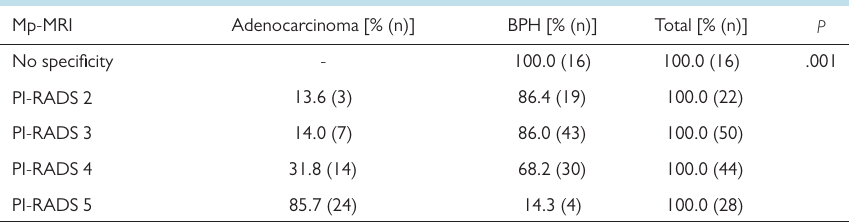
Table 3. The Distributions of the Results of Mp-MRI and Prostate Biopsies